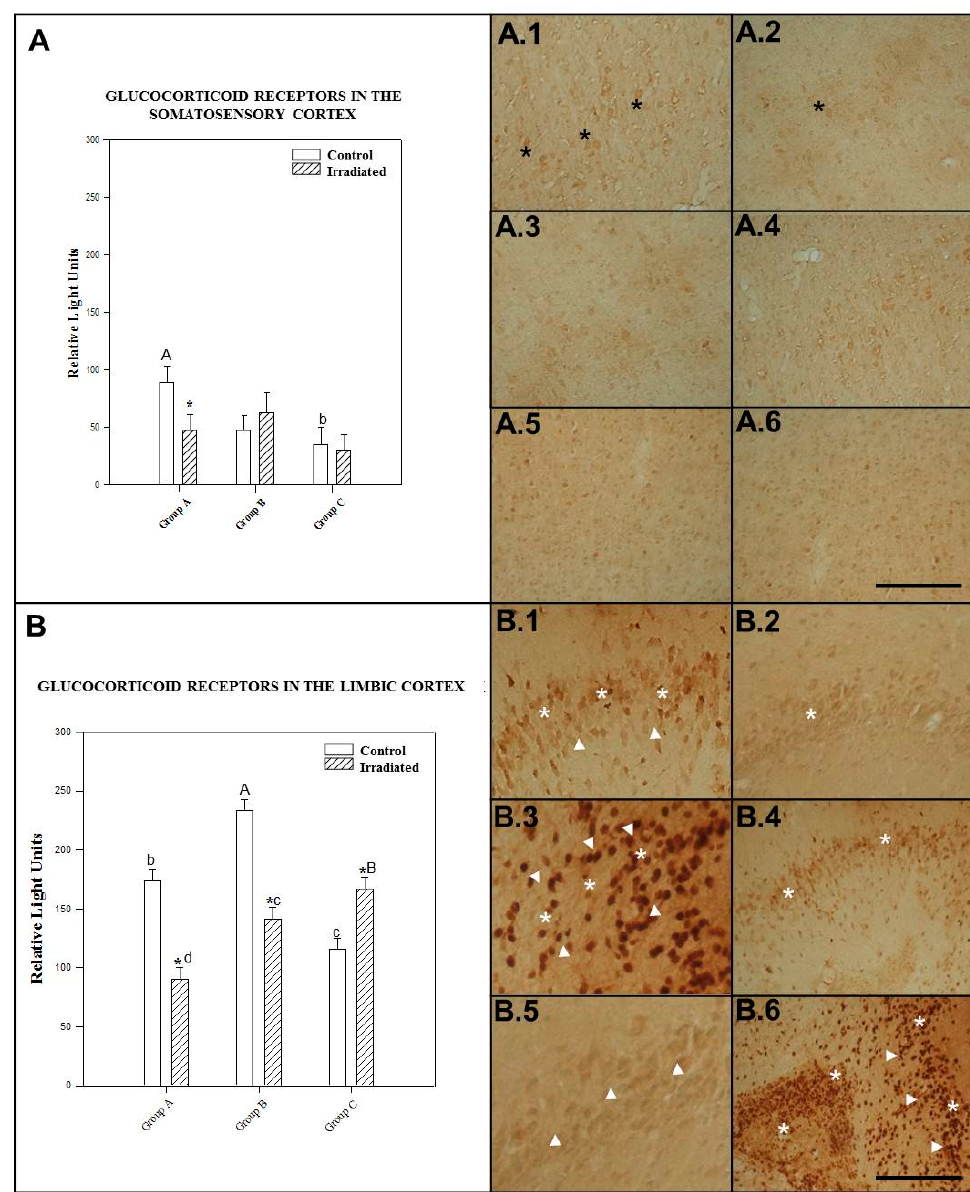
Figure 3. The histograms represent glucocorticoid receptor (GCR) levels detected by ELISA in the somatosensory cortex ( A ) and the limbic cortex ( B ), 1.5 h (Group A) and 24 h (Group B) after acute exposure and 1.5 h after repeated exposure (Group C) to a 2.45 GHz signal at 0 and 3 W. Each bar represents mean ± SEM ( n = 24 samples/per group). Asterisks (*) indicate statistically significant differences ( p < 0.05) between the irradiated and control for each group. a, b, c, d indicate statistically significant differences ( p < 0.05) between irradiated or nonirradiated animals comparing between the different groups A, B, C, which were determined using two-way ANOVA followed by the Holm- Sidak test for multiple comparisons. The photographs show the GCR immunomarkers for groups A, B and C in the somatosensory cortex, control (A.1, A.3 and A.5) and irradiated animals (A.2, A.4 and A.6); in the limbic cortex, control (B.1, B.3 and B.5) and irradiated animals (B.2, B.4 and B.6) ( n = 15 samples/per group). In the photos it is indicate with the arrowhead and asterisk that means increase on regional cytolocalization. Scale bar = 60 µm.